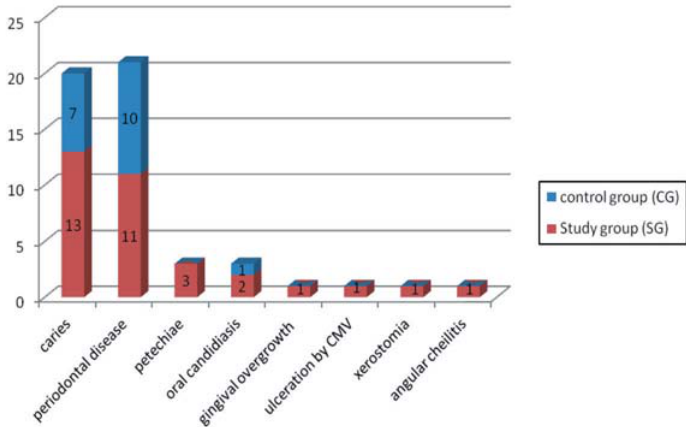
Figure 3- Oral manifestations of study group and control group patients